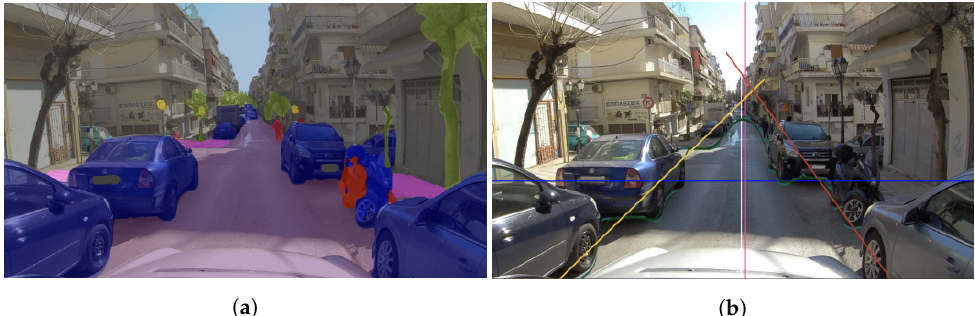
Figure 3. Example of object position estimation pipeline. ( a ) Semantic segmentation with DeepLabv3+ pre-trained in the cityscapes dataset. ( b ) Road width estimation.